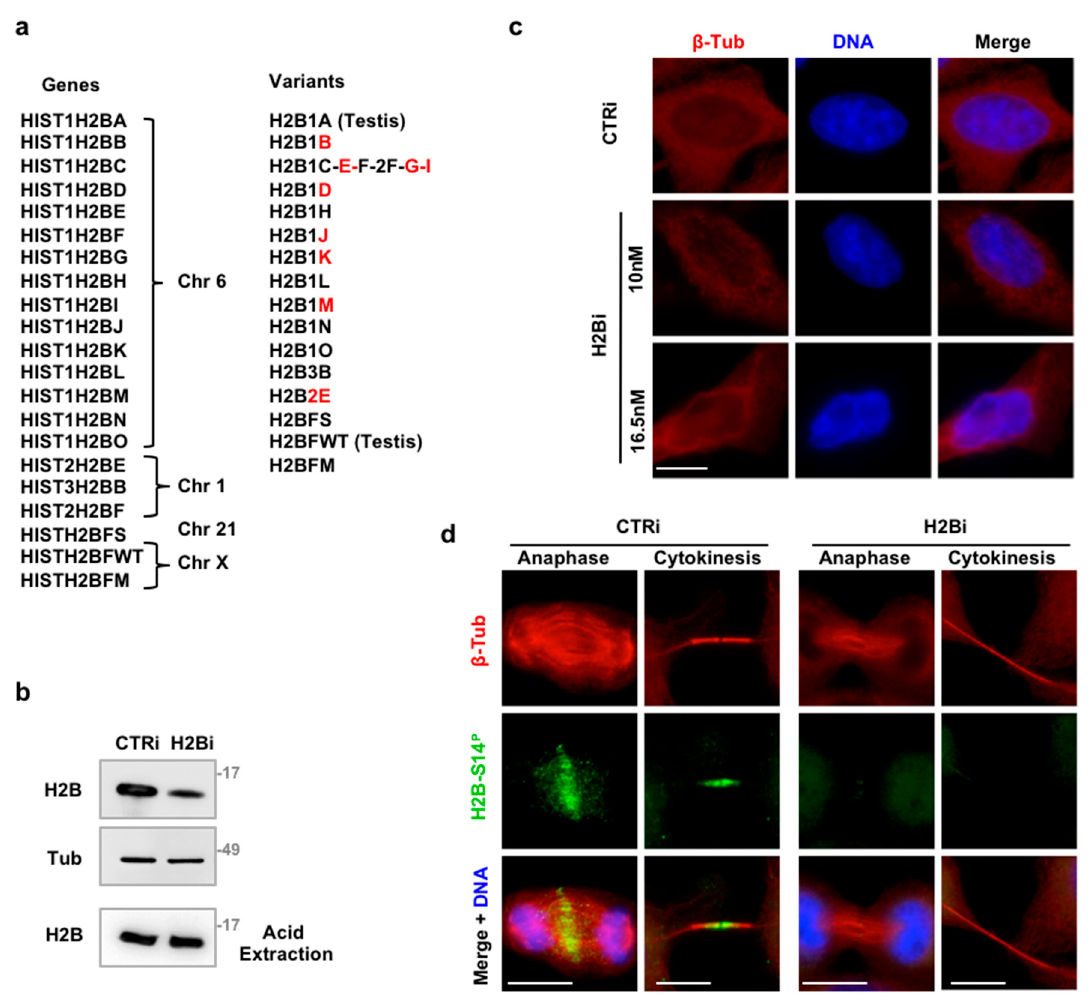
Figure 1. Depletion of ecH2B with siRNAs. ( a ) Schematic representation of H2B isoforms (gene symbol, chromosomal location, and protein name are reported). In red are indicated the isoforms recognized by the nine variant-specific siRNAs. ( b – d ) HeLa cells were depleted for histone H2B with a combination of the nine variant-specific siRNAs (H2Bi) or with universal negative control (CTRi). Representative WB for the indicated proteins is shown. Cells were subdivided in two aliquots and cell extracts obtained with lysis bu ff er and centrifugation to eliminate chromatin or with acid extraction to purify nucleosome histones. ( c ) Representative IF imagines of CTRi and H2Bi HeLa cells—transfected with the indicated molarity of siRNAs—stained with Hoechst (blue) and anti- β -Tubulin Ab (red) to visualize nuclear DNA and cytoplasm. Scale bar is 10 µ m. ( d ) Representative IF imagines of CTRi and H2Bi HeLa cells stained with anti- β -Tubulin Ab (red), anti-phospho-H2B-Ser14 Ab (green) and Hoechst (blue) to visualize nuclei. Representative images of cells in anaphase and cytokinesis are shown. At least 30 anaphase and 100 cytokinetic cells form three independent experiments were analyzed. Scale bar is 10 μ m.